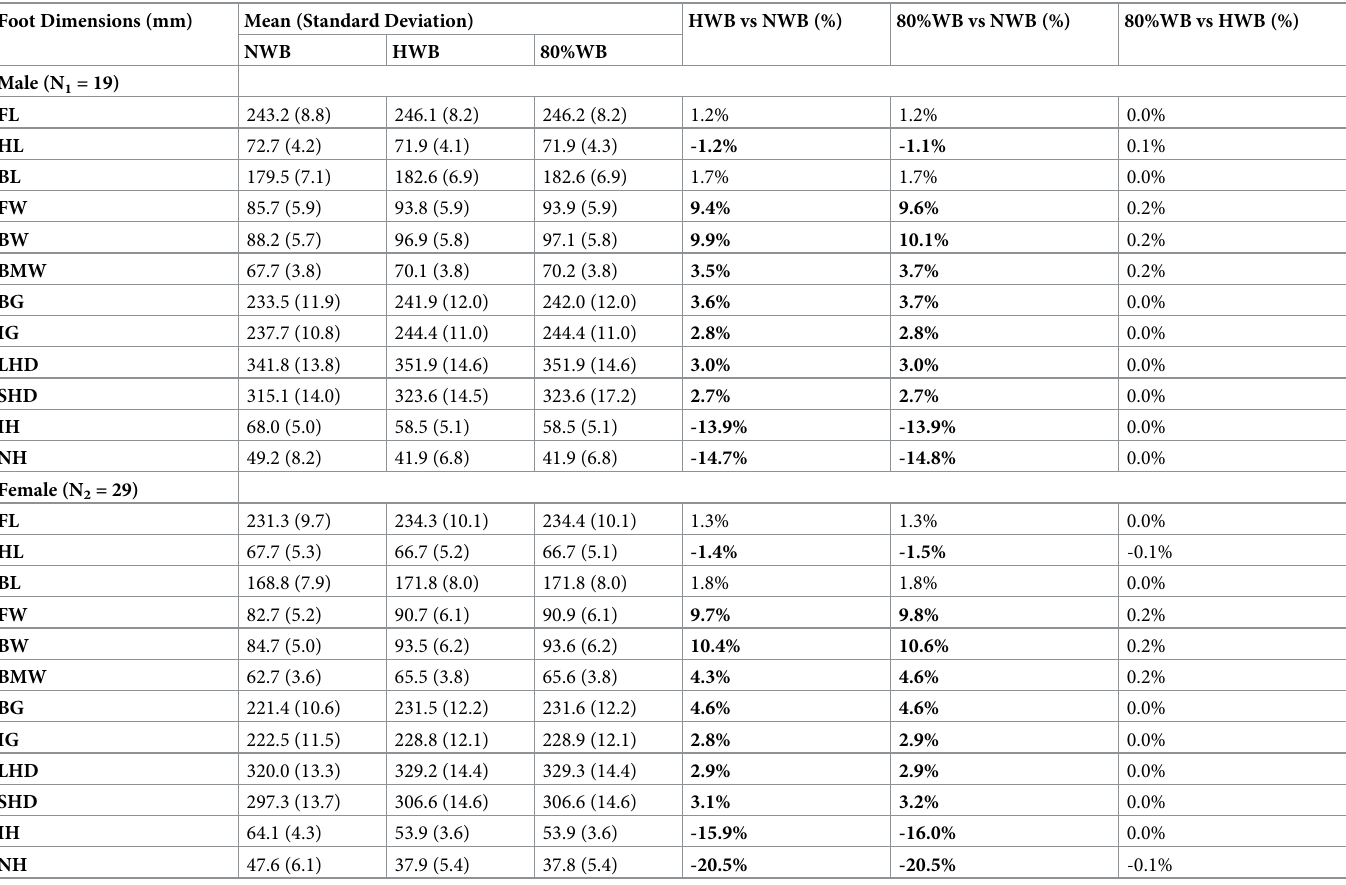
Table 2. ANOVA analysis of foot dimensions for NWB, HWB, and 80%WB